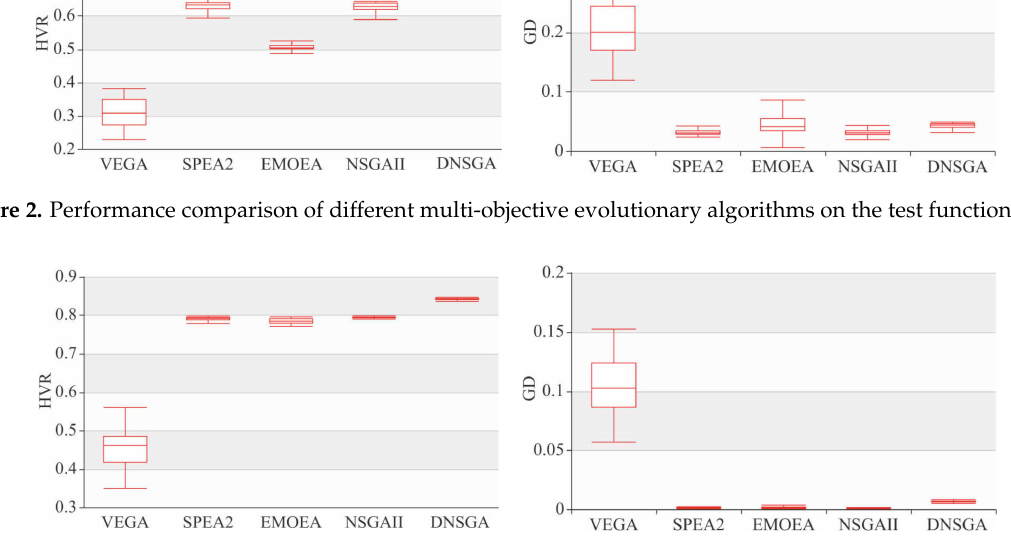
Figure 3. Performance comparison of different multi-objective evolutionary algorithms on the test function ZDT3.